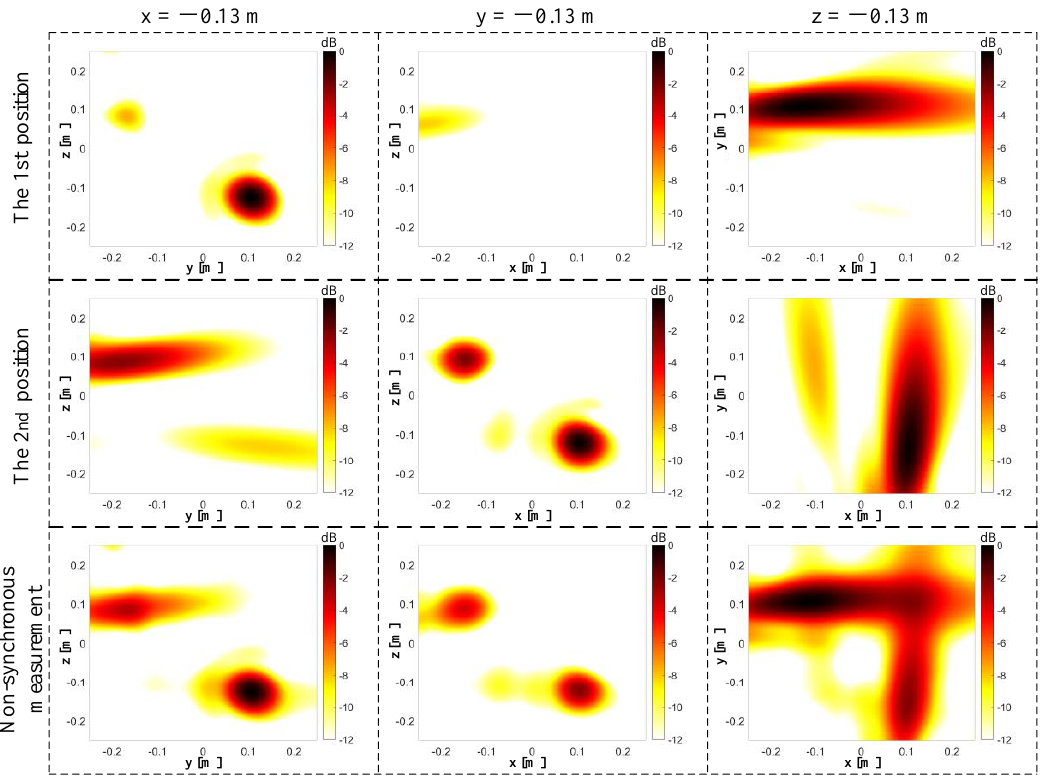
Figure 19. Comparison of the beamforming slices between a single planar microphone array and the non-synchronous measurements. From top to bottom are the 1st position, the 2nd position, and the non-synchronous measurements. From left to right are the x = −0.13 m, y = −0.13 m, and z = −0.13 m slices.